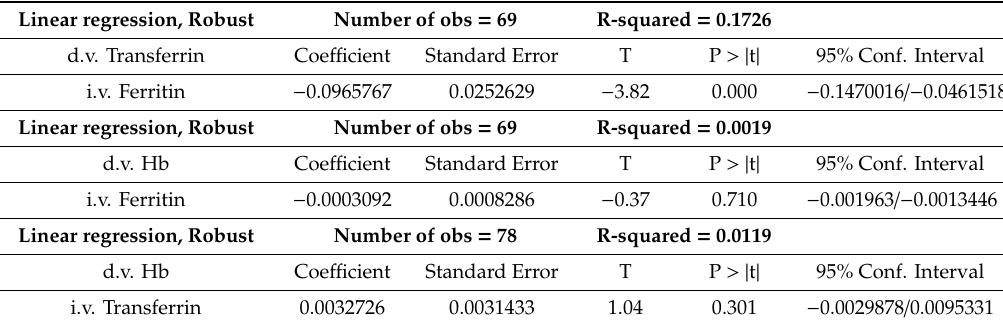
Legend to Table 5. Hb, haemoglobin concentration. The negative prediction of transferrin levels by ferritin concentrations was much expected. Obviously, Hb concentration was not exclusively due to an iron deficit.